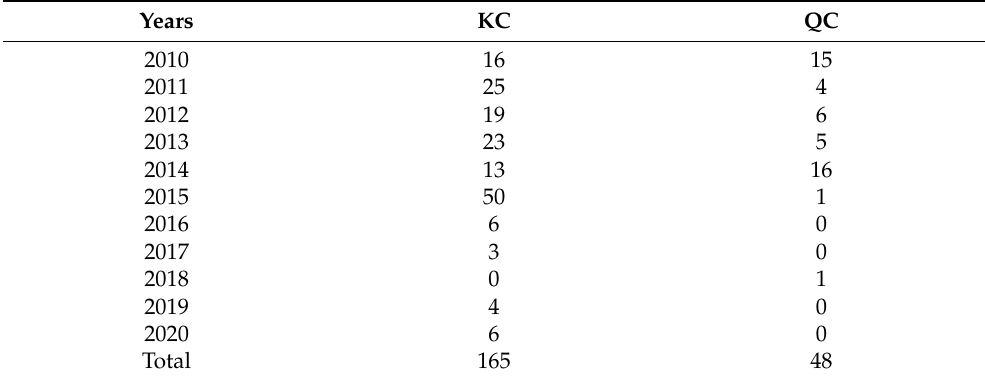
Table 1. Number of yearly MODIS AOD data with corresponding AERONET AOD data used in the analysis in each study